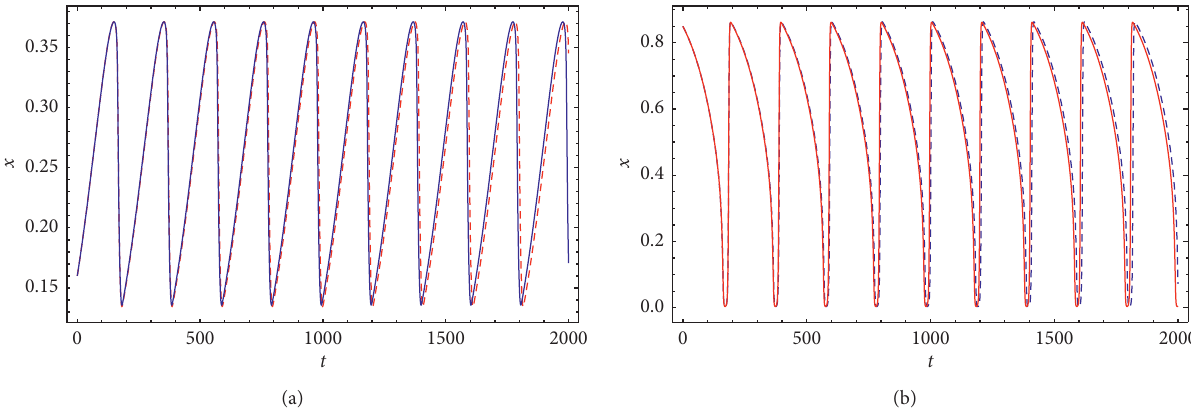
Figure 5: Time series of system (9) and system